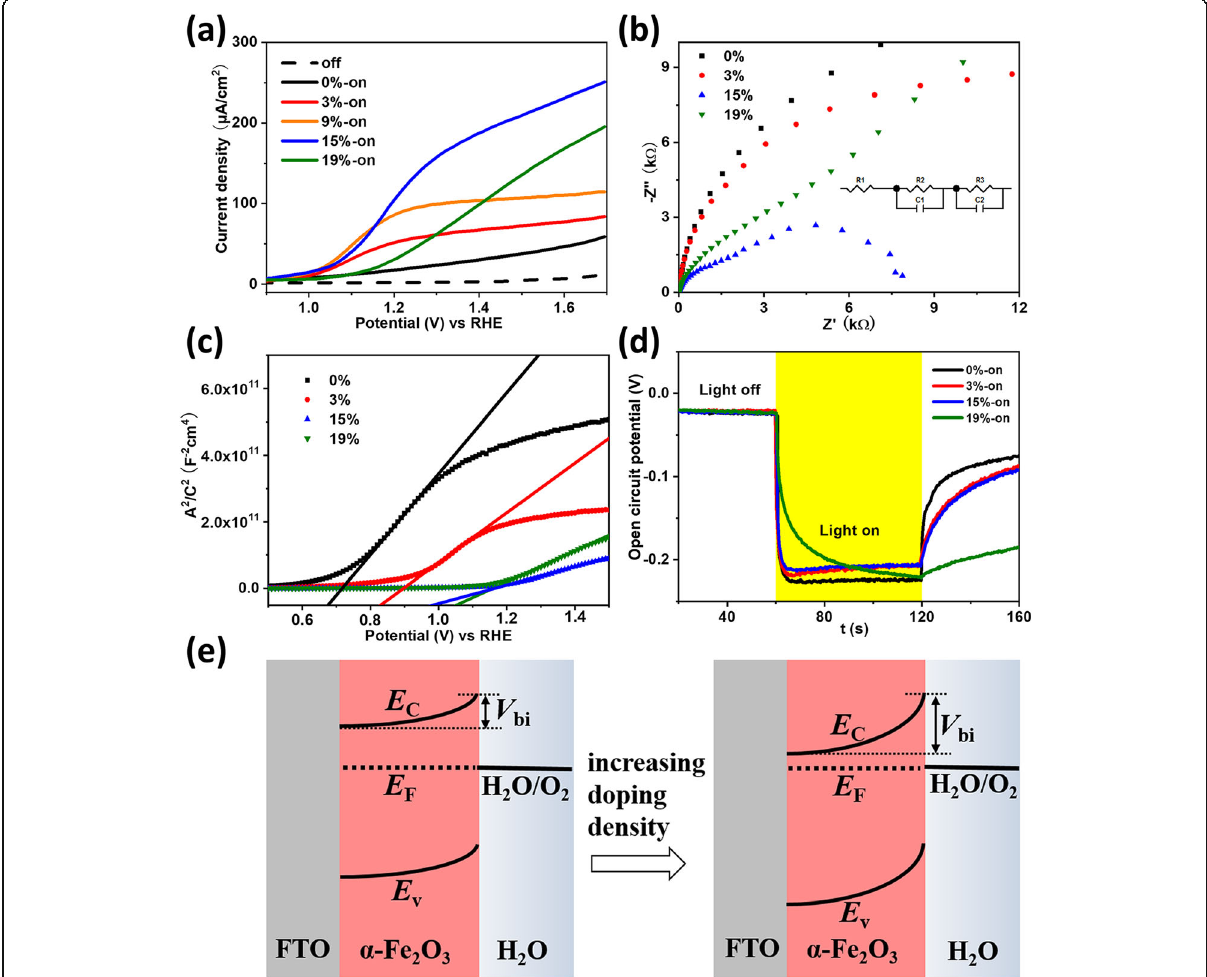
Fig. 3 a J-V curves of the hematite photoanodes with different doping levels in the dark (dashed line) and under one-sun irradiation (solid curves). b Photoelectrochemical impedance spectra measured at 1.23 V RHE . c Mott-Schottky plots. d The change of open circuit potential under the light-on/light-off circle. e Schematic diagram of the equilibrium state of energy band bending in the where C is the capacitance of the space charge region in the change of band bending under switching on or off unit of F, A is the projected area of the photoelectrode the light because photogenerated carriers in n-type semi- (~ 0.5 cm 2 ), N conductors will flatten the upward band bending in the is the doping density, q is electron d dark [40]. The band bending is mainly dependent on the charge, ε is the dielectric constant of hematite (assumed hematite-electrolyte contact situation, like surface re- to be 80), ε is the vacuum permittivity, and E is the ap- 0 combination and built-in potential ( V plied potential. For 15% doped hematite, N increases ). In addition, all d bi from 1.45 × 10 16 to 6.37 × 10 16 cm − 3 by 4.4 times with re- the Sn-doped samples require longer time to achieve a new equilibrium in the change of light-on state to light- spect to the 0% doped hematite. An increase in N from d off state. Excessive doping causes the delay of achieving Table S2 confirms the enhancement of conductivity and equilibrium state due to the slow photoelectron injection the reduction of carrier bulk recombination. The flat into the surface states. Figure 3e shows the schematic band potential ( V ) of the sample with Sn doping grad- FB diagram of the equilibrium state of energy band bending ually shifts to the anodic direction, which confirms that in the dark. When the doping density increases, the the obtainment of plateau photocurrent needs a large Femi level of the doped hematite is gradually enhanced. applied potential. To obtain relative information about So the degree of the energy band bending at equilibrium energy band bending, we tested the open circuit poten- state and the V tial (OCP) under the light-on/light-off circle (Fig. 3d). are larger under a higher doping level. bi − OCP The photo-voltage (i.e., OCP A large V ) represents is beneficial for the separation of the dark light bi